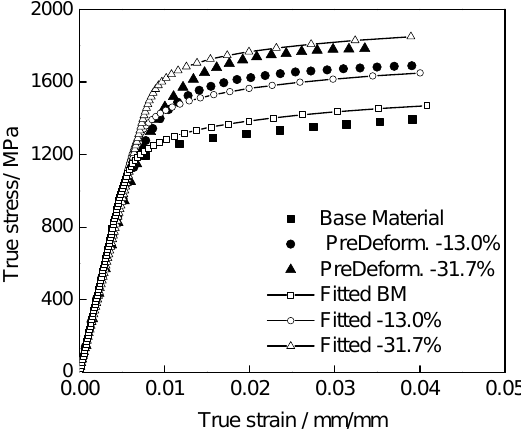
Figure 5. Results of the Stress–Strain relationship fitted with the Ramberg–Osgood Model of the base material and pre-deformed